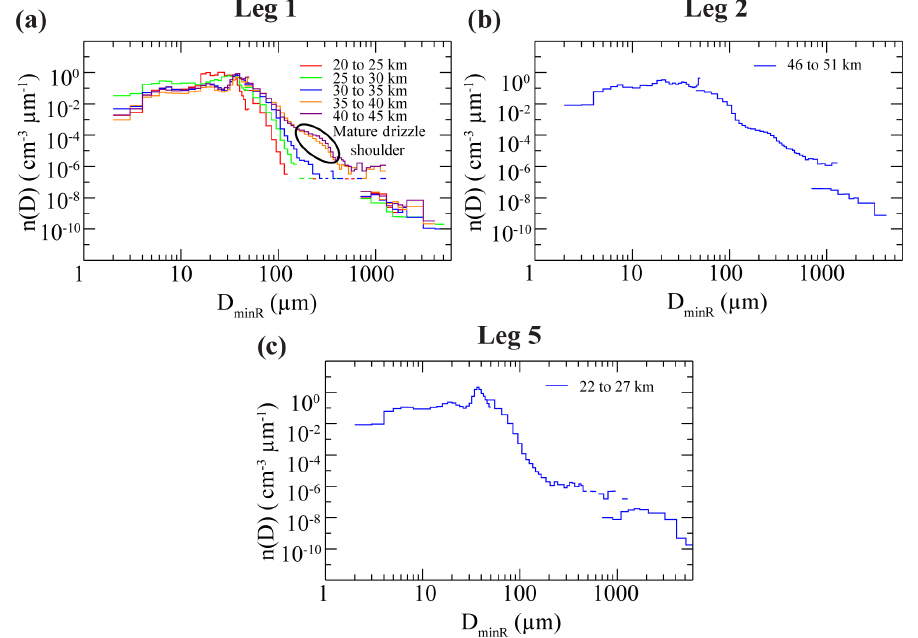
Figure 9. Averaged size distributions for legs 1, 2, and 5 ( a , b , and c , respectively) from the CDP, 2DS, and 2DP cloud and precipitation probes. Each of the blue composite size spectra correspond to the averaged size distributions at flight level during the CFADs in Fig.